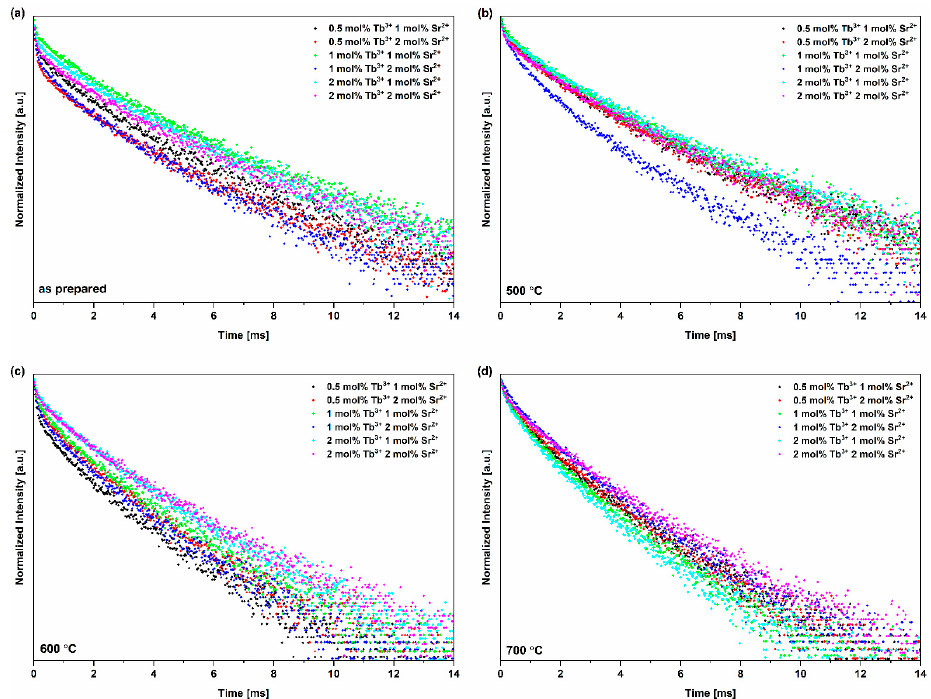
Figure 7. Fluorescence decay time of series ( a ) thermally untreated (as prepared), ( b ) annealed at 500 °C, ( c ) annealed at 600 °C and ( d ) annealed at 700 °C at an excitation wavelength of 266 nm and an observation wavelength of 545 nm ( 5 D 4 → 7 F 5 transition). For all obtained materials, the fluorescence decay is not monoexponential.